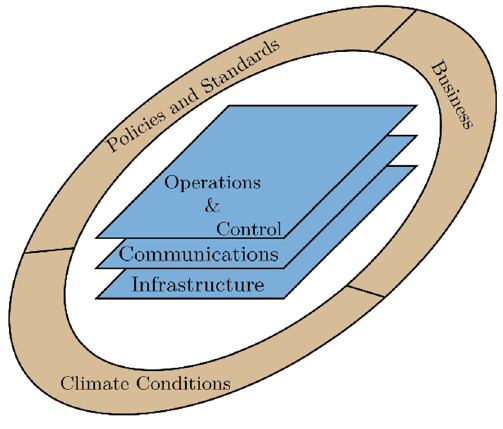
Figure 2. Microgrid layer structure.